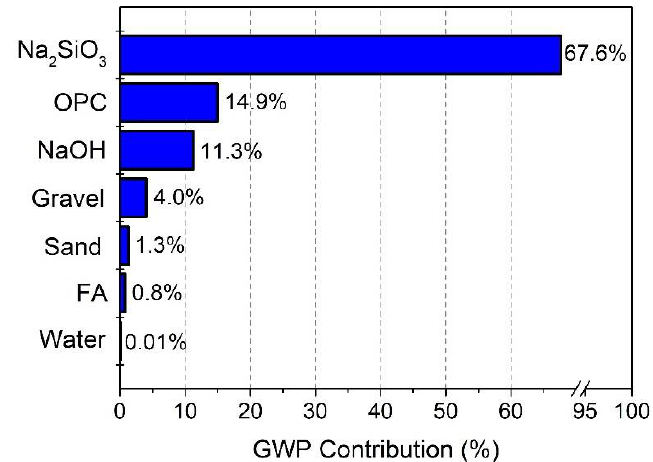
Figure 17. Percentage contribution of raw materials to the GWP of the alkali-activated hybrid concrete (90% FA–10% OPC).